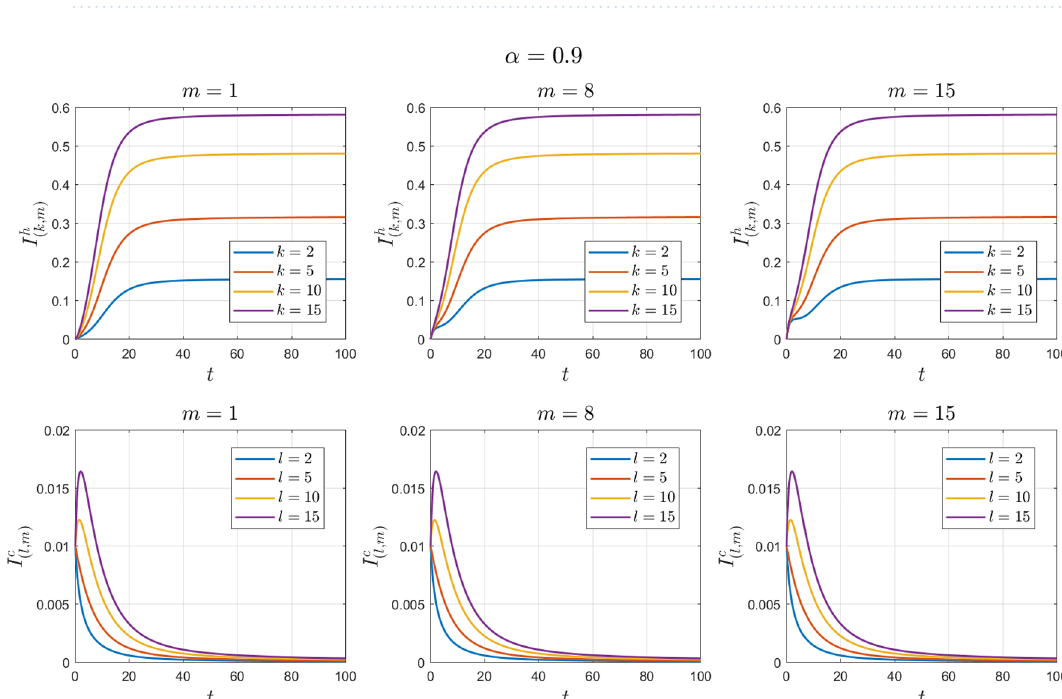
Figure 6. Numerical solutions of Example 3 for α = 0.8 .